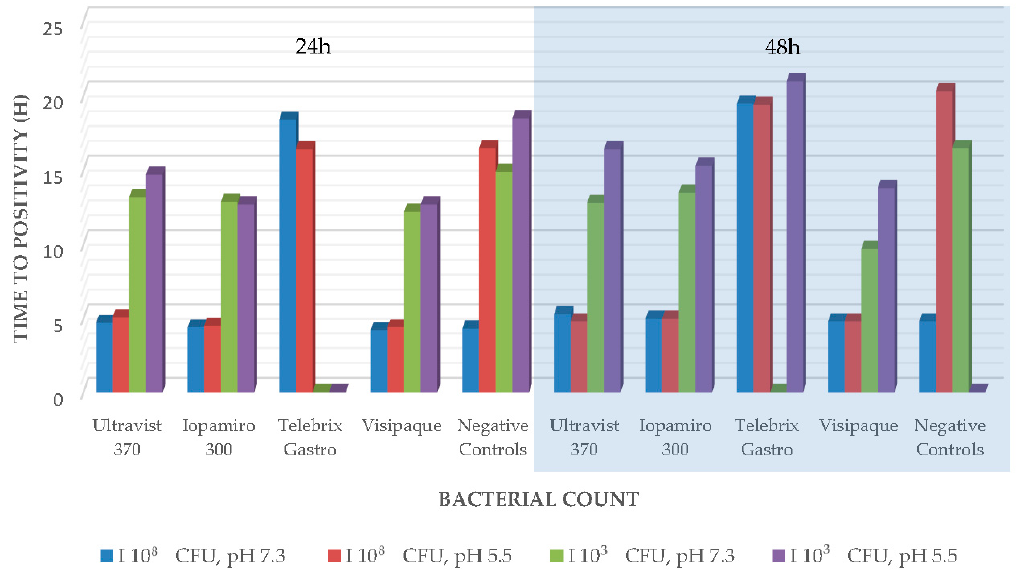
Figure 2. Antibacterial efficacy tests in liquid culture P. aeruginosa.